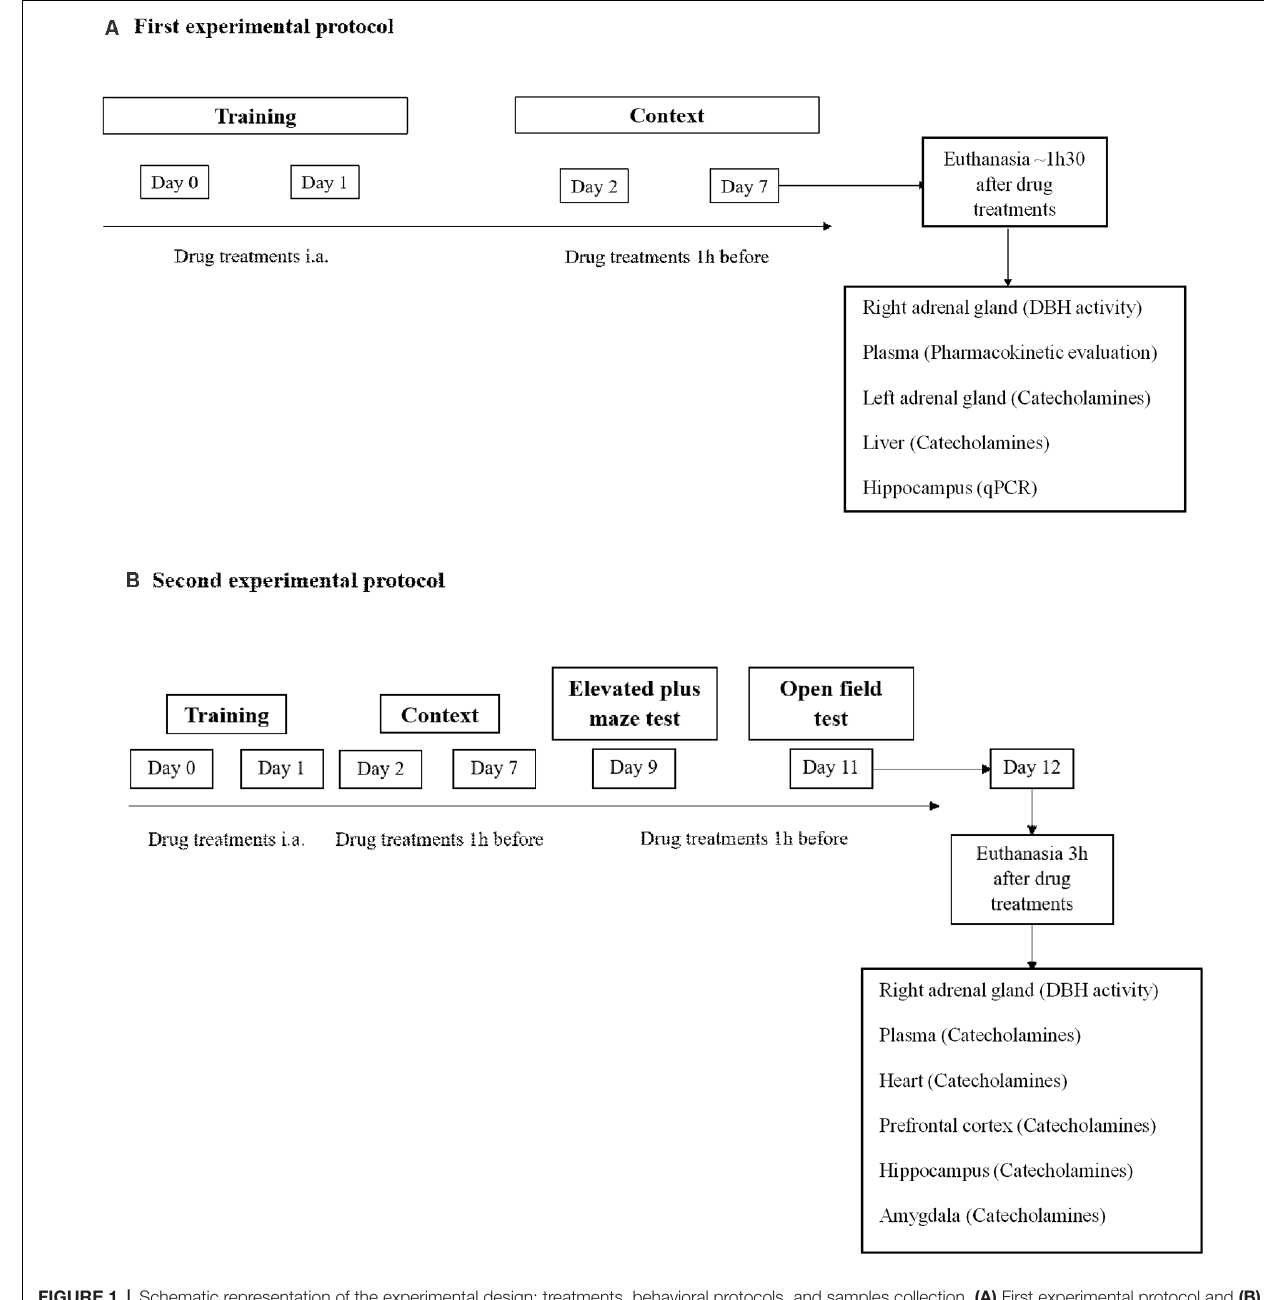
FIGURE 1 | Schematic representation of the experimental design: treatments, behavioral protocols, and samples collection. (A) First experimental protocol and (B) second experimental protocol. i.a., immediately